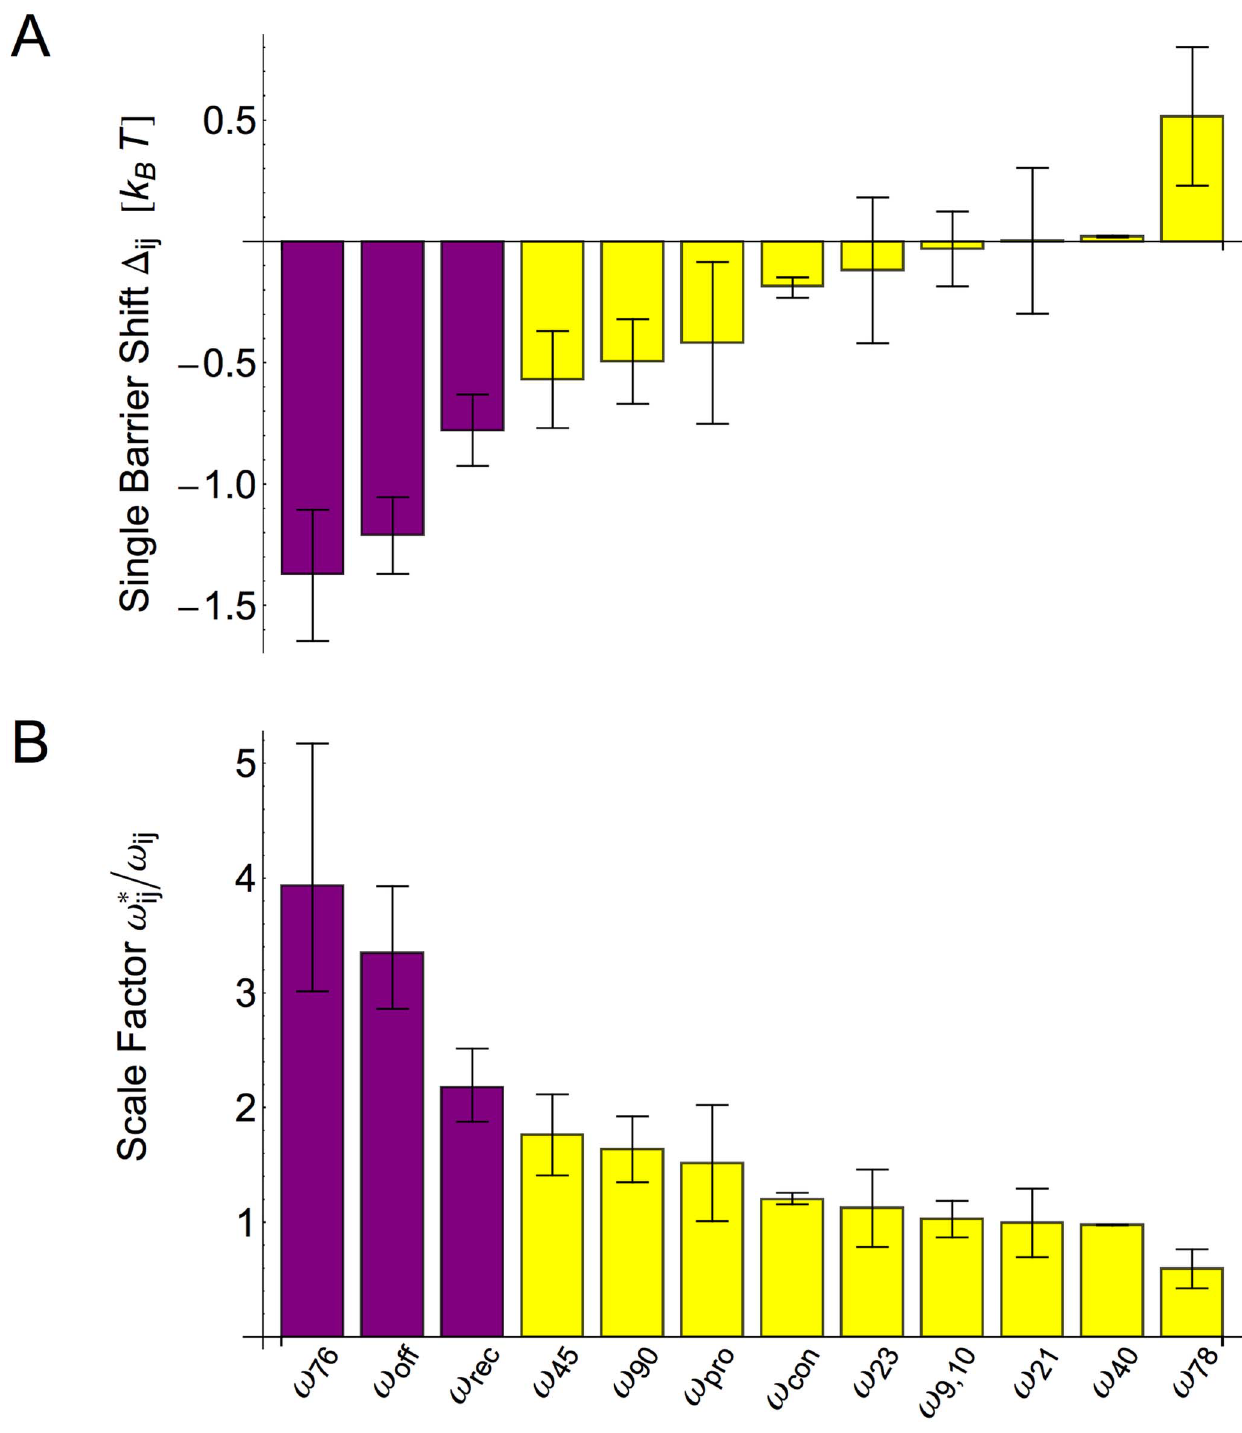
Figure 5. Quantitative comparison between the in-vitro kinetics of translation elongation at 37 6 C and the in-vivo kinetics as deduced for the growth condition of 2.5 dbl/h. (A) Single barrier shifts D ij for the individual transition rates, see Eq. 2 and Fig. 2; and (B) Scale = v ij ~ exp( { D ij ) for all individual transitions of the ribosomes. A barrier shift D ij v 0 implies that the in-vivo rate v ? factors v ? ij to the in-vitro rate v ij .